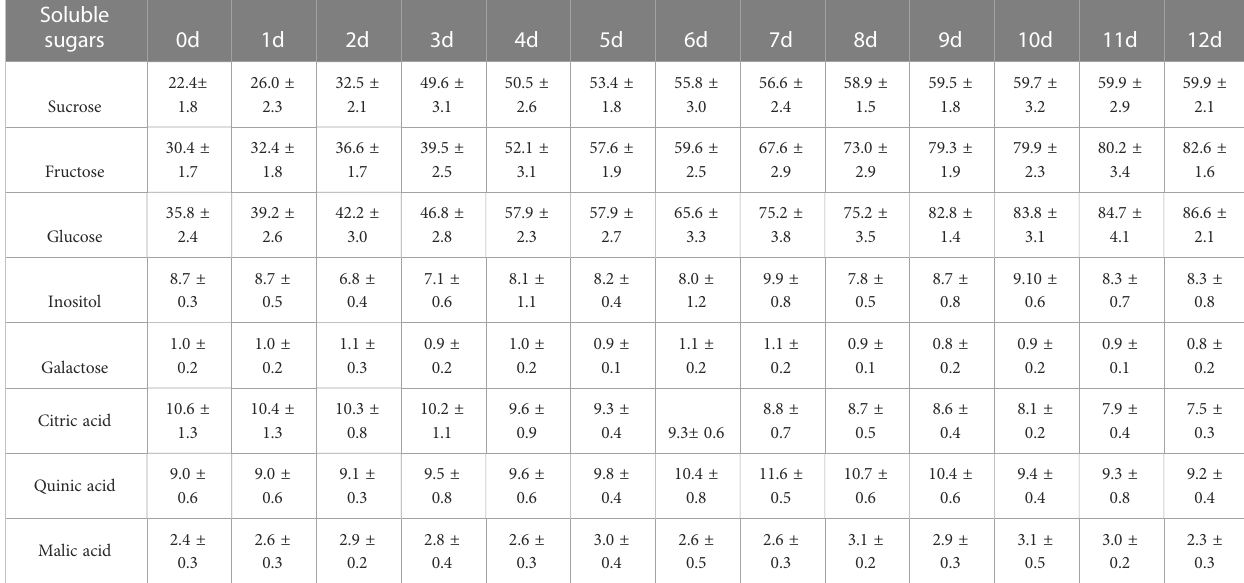
TABLE 1 Contents of major soluble sugars and organic acids at different ripening stages in ‘ jinyan ’ kiwifruit (mg/g). Soluble sugars